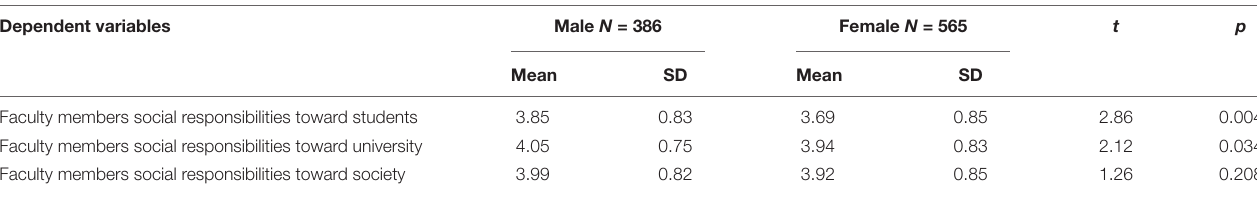
TABLE 6 | T -test on gender and faculty members’